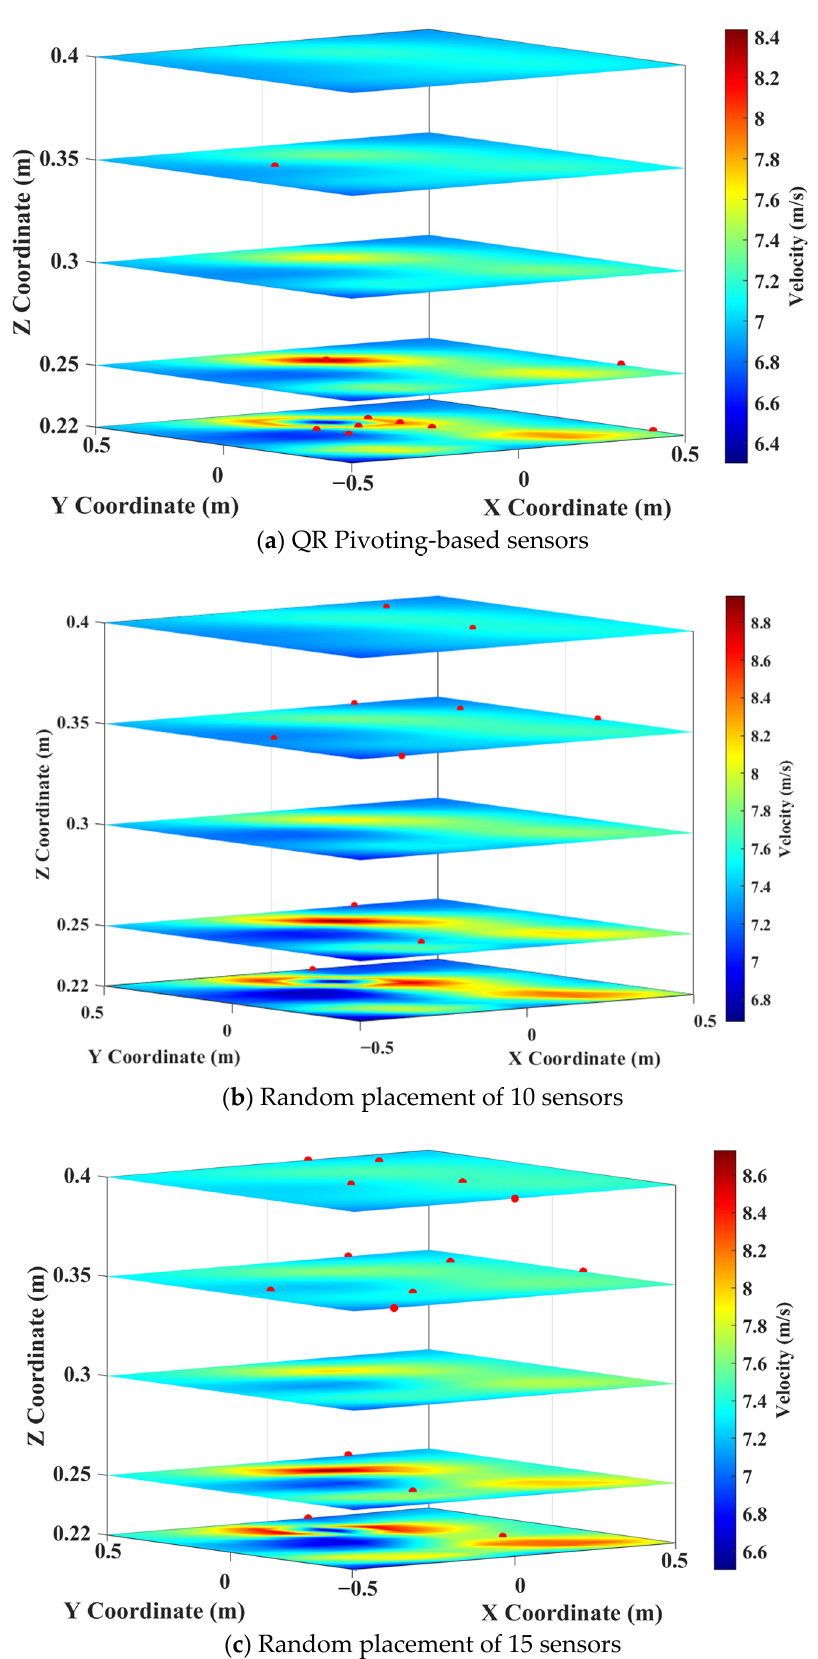
Figure 27. Reconstructed velocity nephograms and sensor locations.